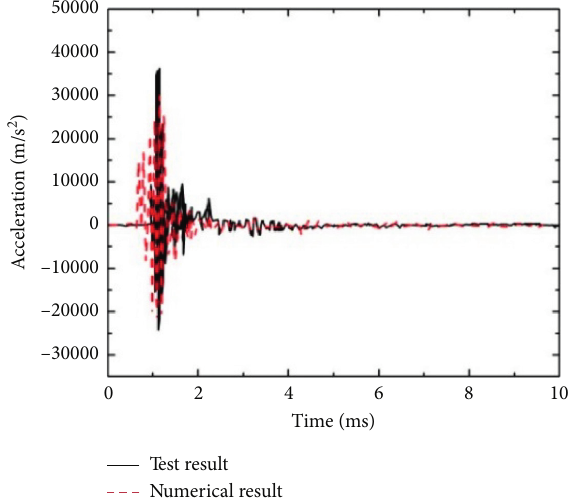
Figure 9: Acceleration history curve of the test point on the column.